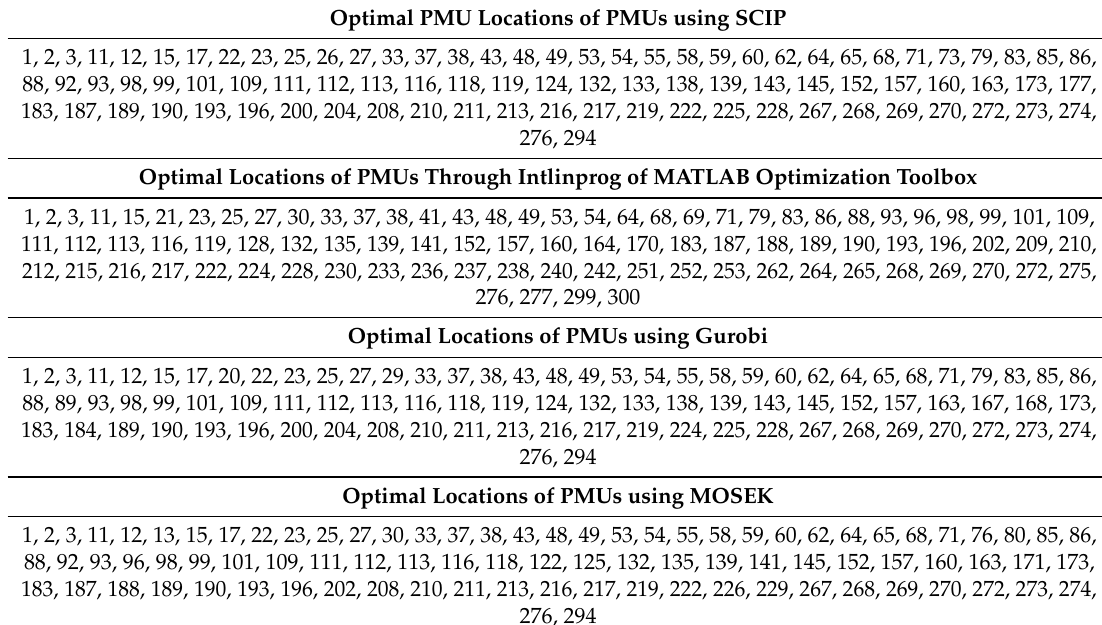
Table A2. Optimal PMU locations for IEEE 300- bus systems.